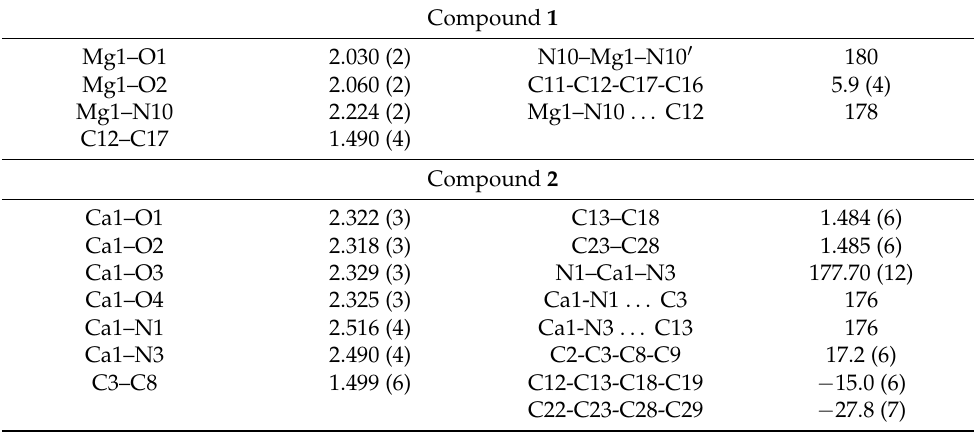
Table 1. Important bond lengths [Å] and angles [ ◦ ] of compounds 1 and 2 .